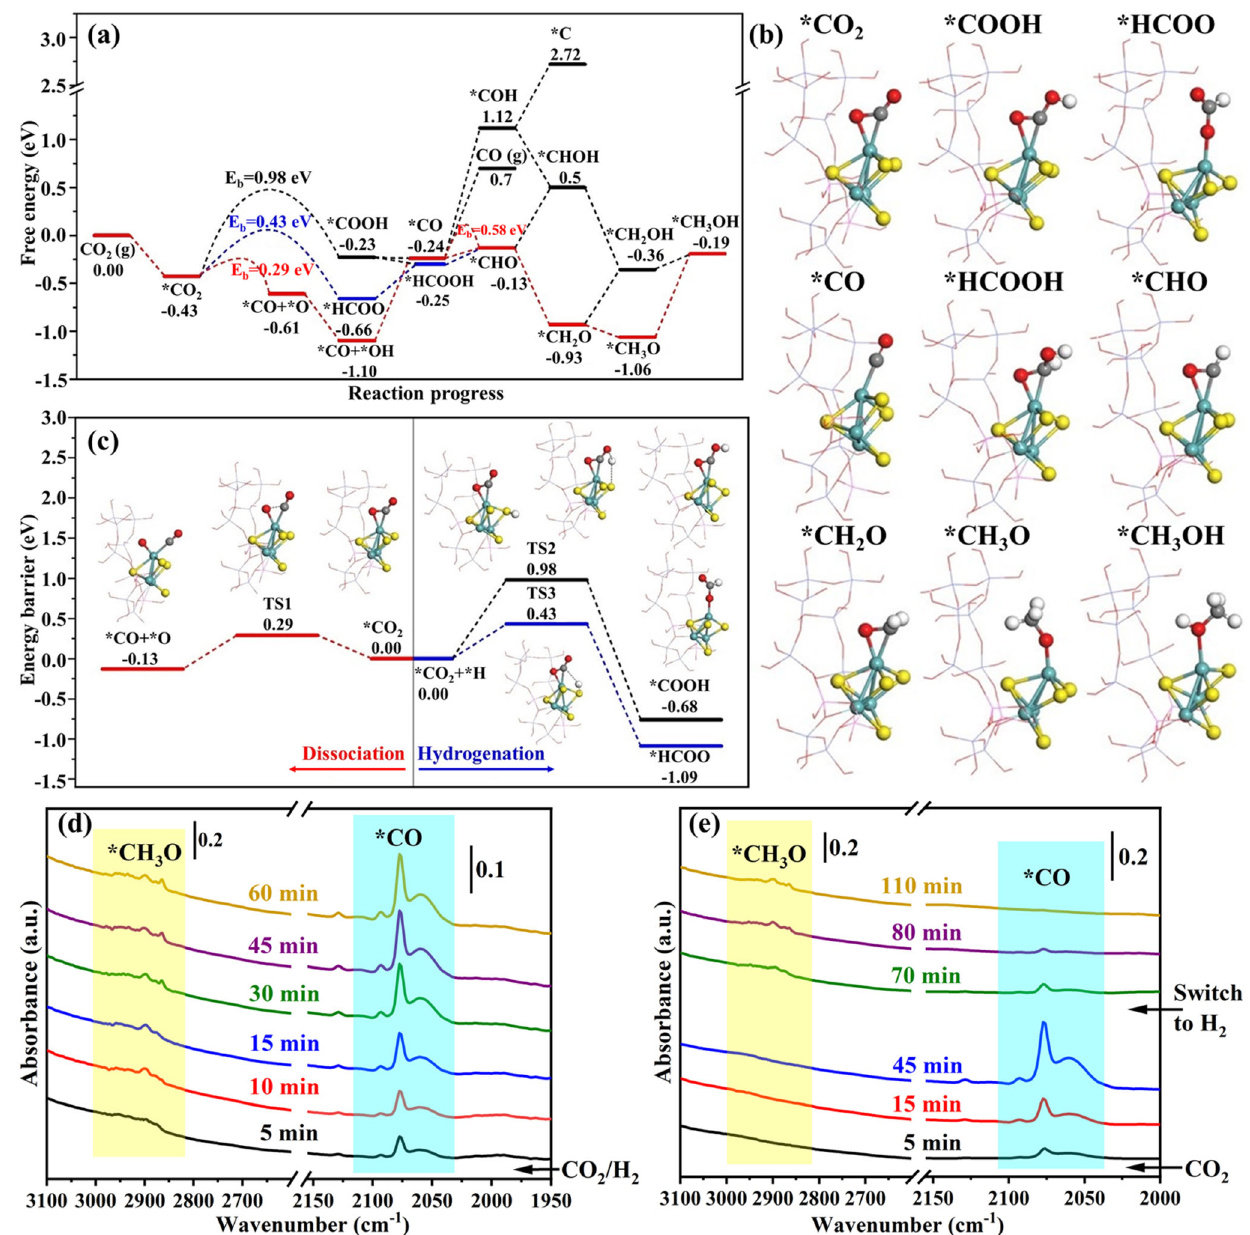
Fig. 5|StudyonthereactionmechanismofCO 2 hydrogenationtoCH 3 OHover Mo 3 S 4 @NaZSM-5. a Free energy diagram of CO 2 hydrogenation to CH 3 OH over Mo 3 S 4 @NaZSM-5 catalyst and kinetic energy barrier (E b ) of the key rate- determining step; b Possible intermediates for CO 2 hydrogenation to CH 3 OH over Mo 3 S 4 @NaZSM-5; c Potential energy surface of *CO 2 dissociation to *CO and hydrogenation to *COOH and *HCOOH over Mo 3 S 4 @NaZSM-5 catalyst; d Operando FT-IR spectra of Mo 3 S 4 @NaZSM-5 catalyst during the hydrogenation